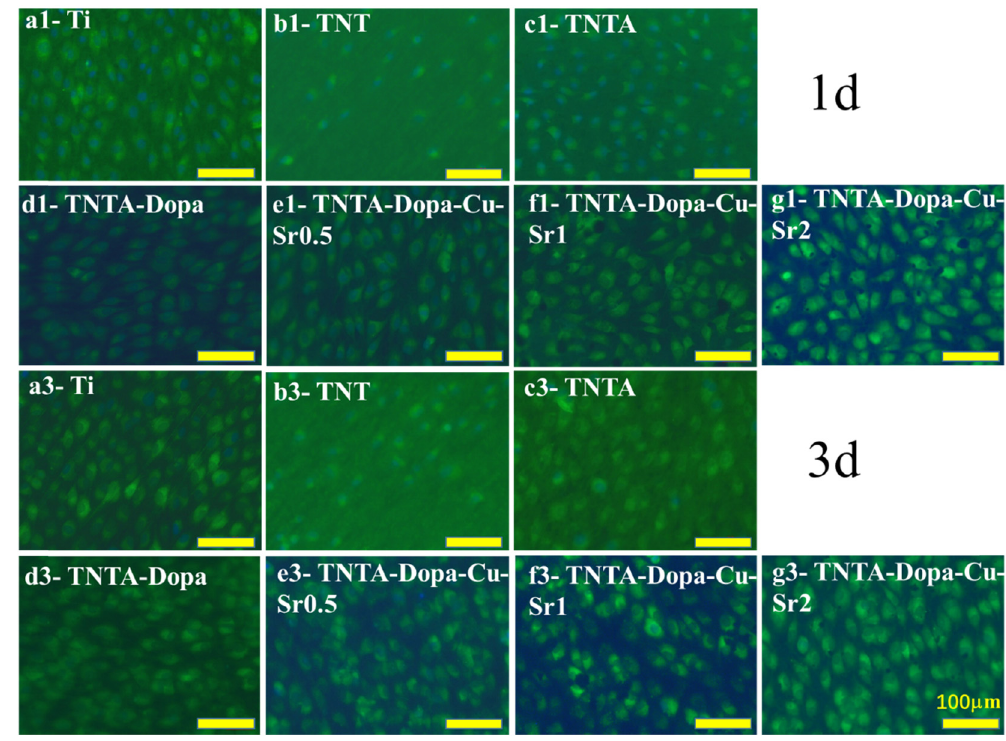
Figure 7: The fl uorescent images of the endothelial cells adhered to the di ff erent